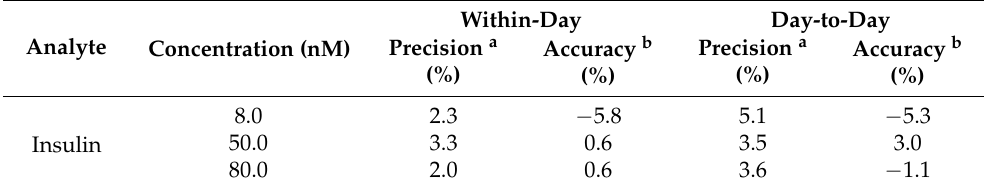
Table 2. Within-day and day-to-day precision and accuracy for the EME-MALDI/MS analysis of insulin in urine samples (n = 5).